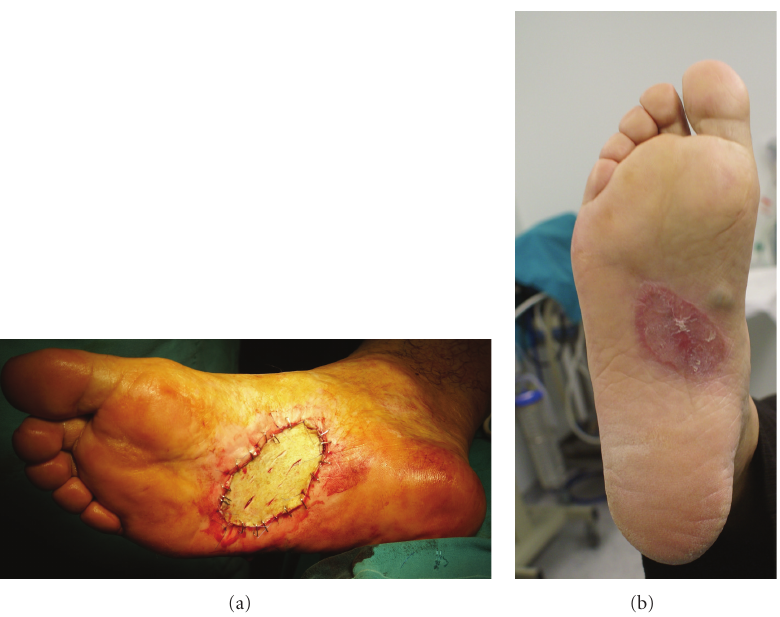
Figure 3: Use of a split-thickness thick ( > 0.016 inches) skin graft from anterior surface of the right thigh in order to reconstruct the excisional defect and provide an excellent aesthetic